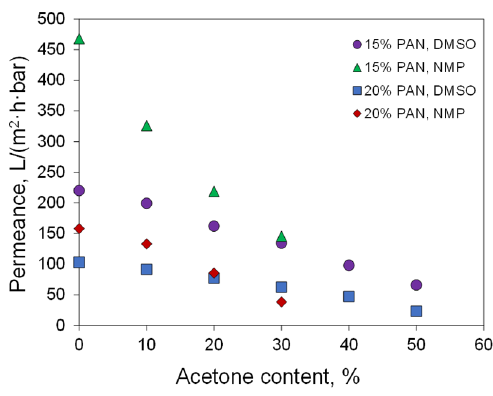
Figure 12. The dependence of water permeance obtained by the NIPS method on the acetone content in the casting solution.